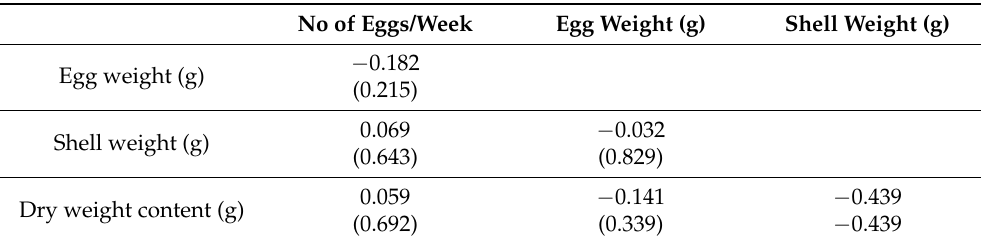
Table 3. Pearson’s correlation coefficients ( σ ) and significance in brackets ( p -value) between laid eggs and egg weight for the two groups of partridges across the experimental